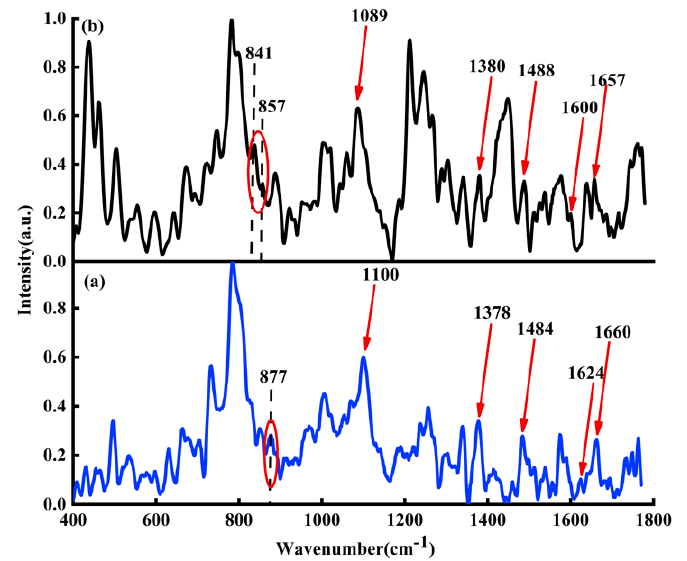
Figure 3. ( a ) Raman spectra of ctDNA solution (blue line) and ( b ) Raman spectrum of DOX-DNA complex (black line). The molar ratio of base-pair versus drug is two.